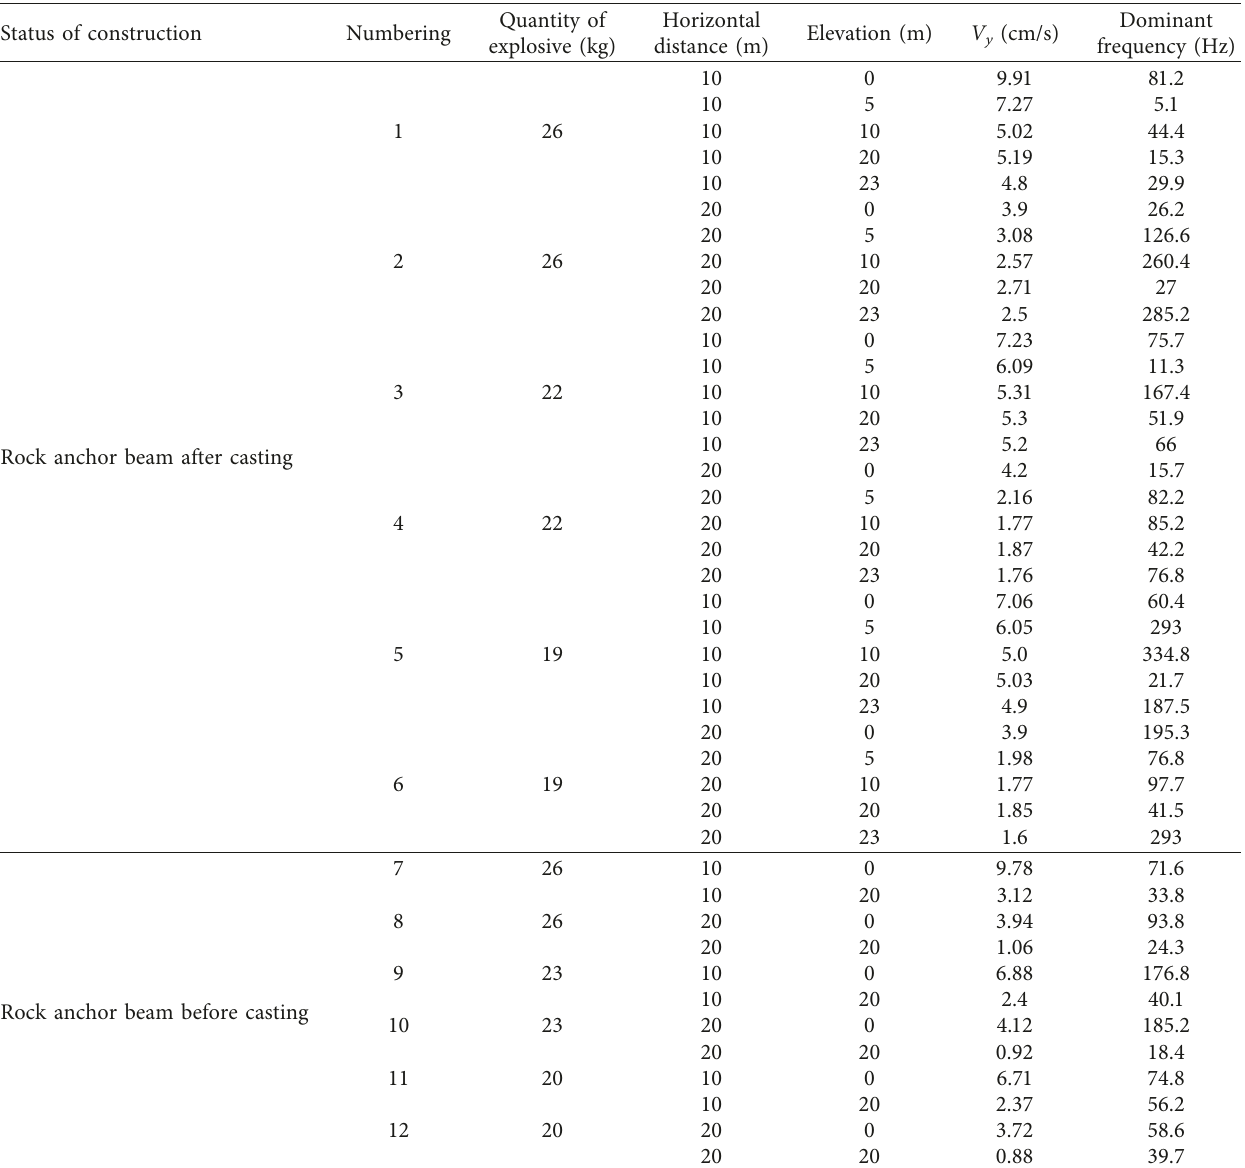
Table 1: Summary of the test results of the blasting vibration in the elevation direction in the